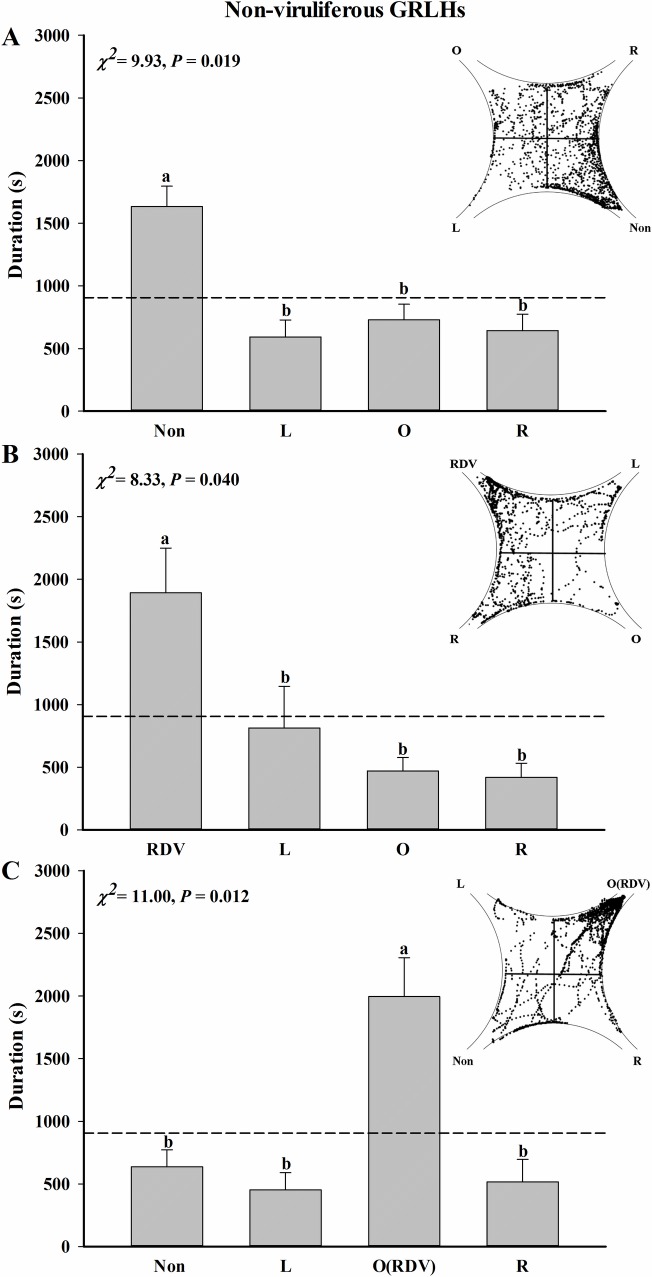
Odor selection preferences of non-viruliferous GRLHs exposed to rice plant volatiles.Preferences were determined as times individual insects invested in each field of a four-field olfactometer during 1 h experiments. (A) RDV-free rice plants were placed in one odor source, with the other three fields charged with filtered clean air (n = 18). (B) RDV-infected rice plants were placed in one odor source, with the other three fields charged with filtered clean air (n = 15). (C) RDV-free and RDV-infected rice plants were placed in opposite fields (n = 20). The orientation of the fields is indicated relative to the field laced with the test odor: Non, RDV-free rice plants; RDV, RDV-infected rice plants; L, left; O, opposite; R, right. Scatter diagram show examples of location of single tracer GRLH per second during a 1 h experiment. The broken line at 900 s indicates an equal amount of time in all fields. Deviations from equal distribution were tested with a Friedman-ANOVA (P < 0.05). Bars annotated with different letters were significantly different from each other (Wilcoxon-Wilcox test).